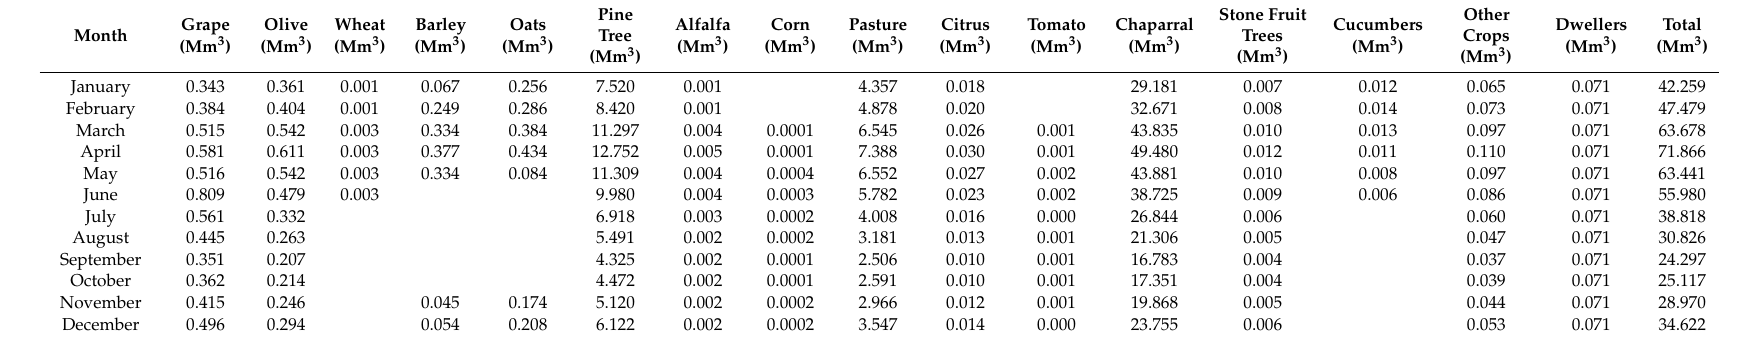
Table 5. Volume of water required for crops and population demand Mm 3